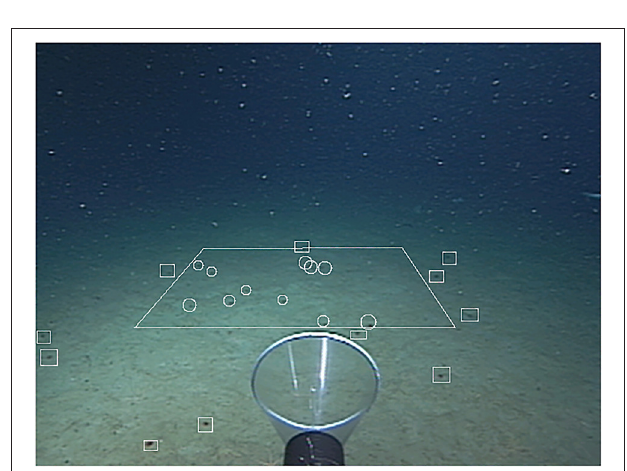
FIGURE 4 | A one square meter quadrat superimposed on video from the ROV Tiburon (04/15/2000, dive #132) to illustrate the abundance of Benthocodon pedunculatus. Medusae within the quadrat ( n = 11) are encircled and medusa outside the quadrat have squares drawn around them. Depth is 3,009m in the Monterey Submarine